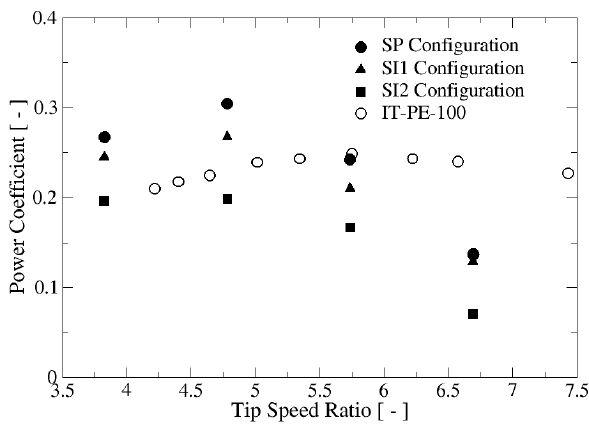
Figure 17. The comparison of the CFD results obtained in the present study versus the efficiency curve of the IT-PE-100 wind turbine.